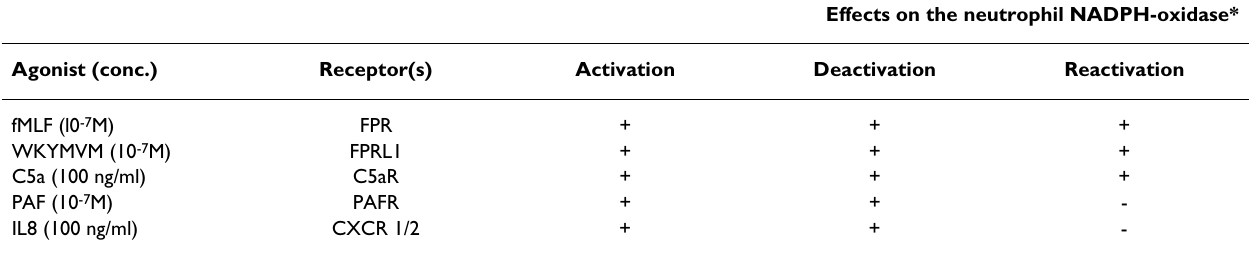
Effects on the neutrophil NADPH-oxidase*